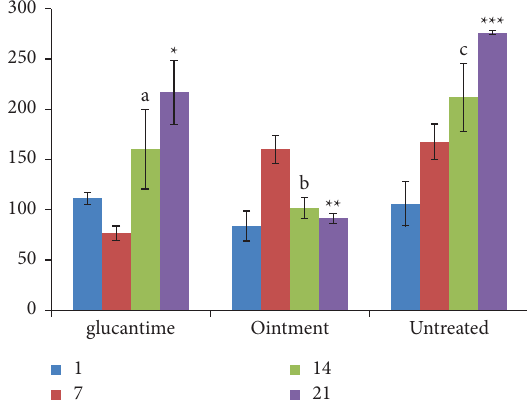
Figure 3: Changes in the surface area of the lesions (mean ± SE) of diferent experimental groups during treatment with luteolin/ AgNPQct